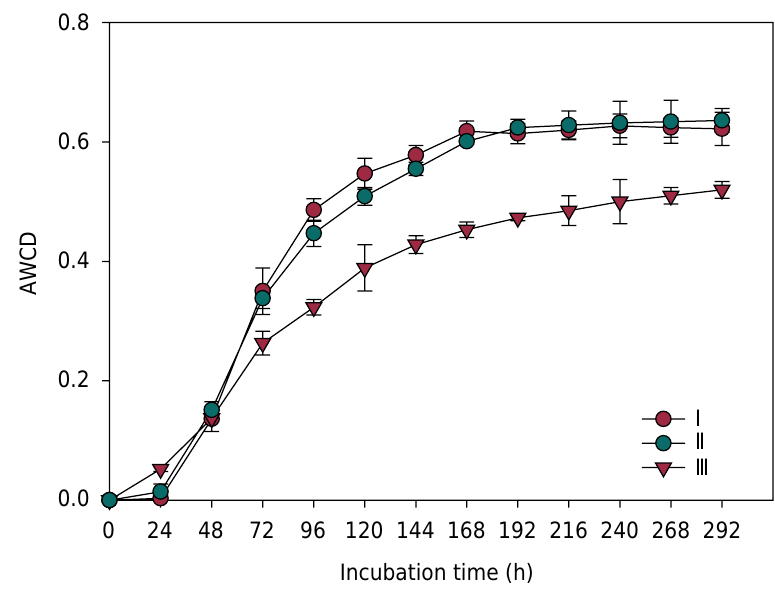
Figure 1. Average well color development (AWCD) obtained by Biolog-Eco Plate TM incubation of all treatments. Treatment: Ⅰ, control; Ⅱ, pre-emergence after sowing herbicide spraying; Ⅲ, post-emergence stem, and leaf herbicide